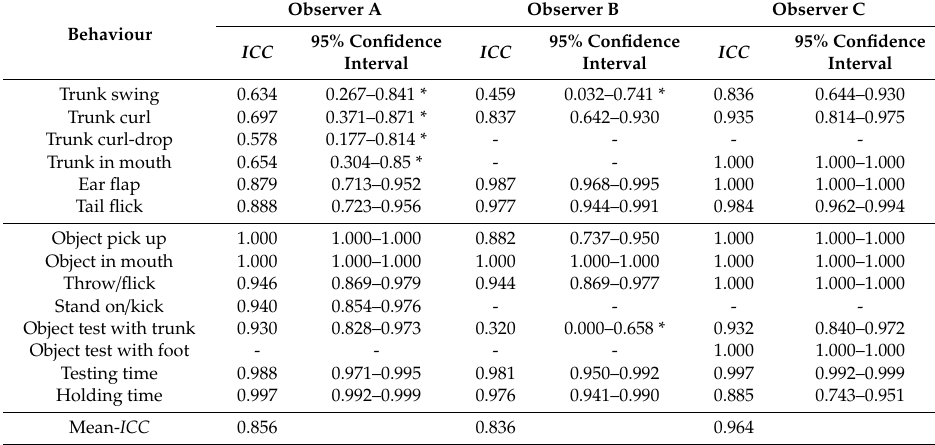
Table 3. Within-observer reliability, 95% confidence intervals and mean- ICC for each observer. General behaviours (Table 1a) above the dotted line and object-directed behaviours (Table 1b)